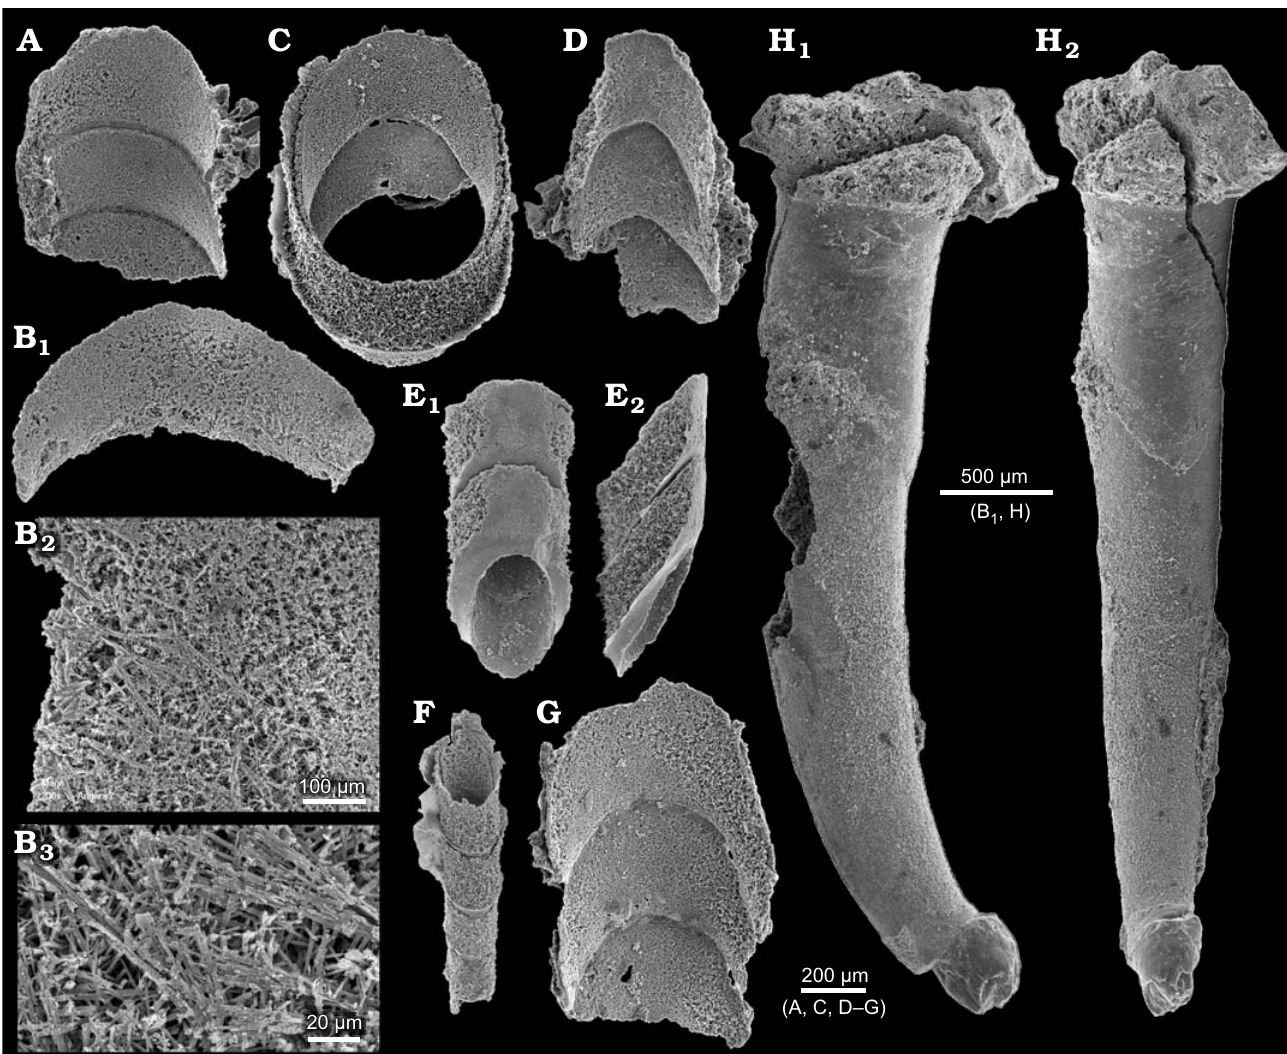
Fig. 8. A – G . Phosphatised siphuncle connecting rings of ellesmeroceratid nautiloids (interpreted below as Ruthenoceras elongatum Korde, 1949) from sample Ang-6, block No. 2, probably latest Furongian Ust-kut Formation found at Pashino on the Angara River, Siberia, Russia. ZPAL N. IV/152, 148, 147, 153, 151, 149, 150, respectively. Specimens in dorsal views, also details in higher magnification (B 2 and B 3 ; see also Dzik 2010: fig. 7f), except ventral (E 1 ) and lateral (E 2 ) views. ZPAL N. IV/148 and 150 (see also Dzik 2010: fig. 7b and c). H . For comparison the earliest Cambrian (Tommotian) “hyolith” Turcutheca crassaecochlia Syssoiev, 1962, ZPAL MoXX/7 from the Tommotian ( Dokidocyathus lenaicus Zone) at Bydyangaia on the Lena River, central Yakutia of possible distant cephalopod affinity, probably mature specimen with displaced embryonic part preserved as a glauconitic internal mold, lateral (H 1 ) and posterior (“ventral”) (H 2 ) views (see also Dzik 2010: fig. 7b and